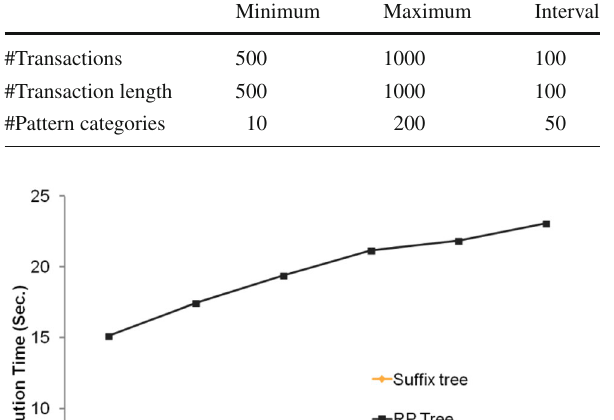
Fig.13 Execution time of the compared methods under different num- bers of pattern